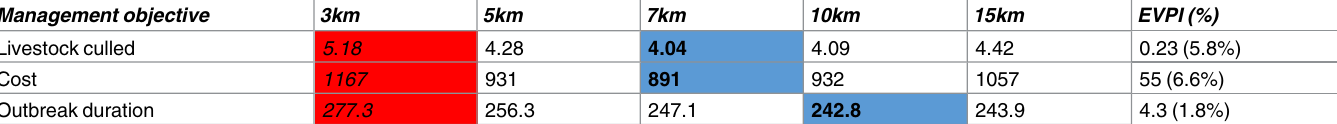
Table 1. Expected livestock culled (million head), outbreak cost (£million) and outbreak duration (days) for each of the control strategies under the assumption of equal weighting across the 27 vaccination parameterisations. Valuesin blue represent the optimalcontrol strategy to minimisethe management objectiveof interest and values in red represent the worst strategy. The final column shows the EVPI and % EVPI for each cost